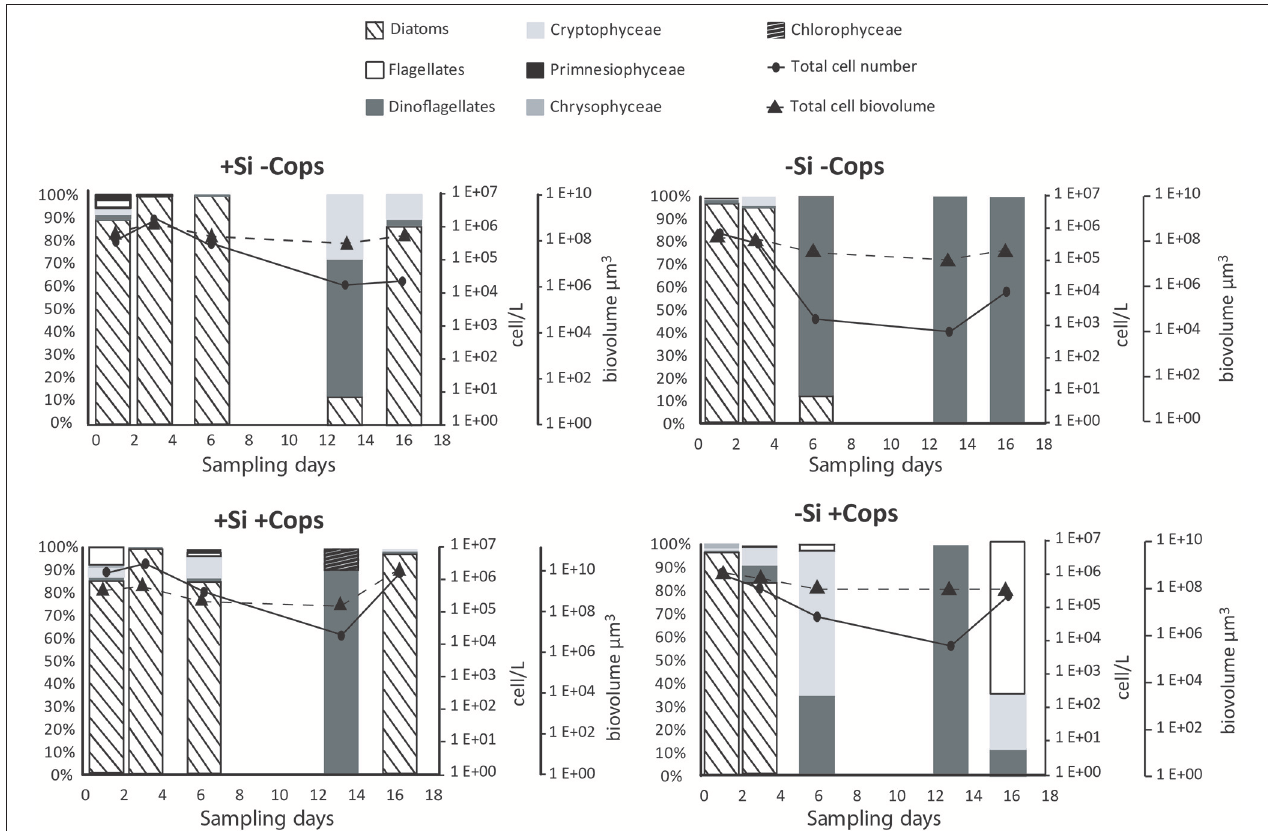
FIGURE 6 | Phytoplankton community structure in the different mesocosm treatments, in percentage, total cell numbers and